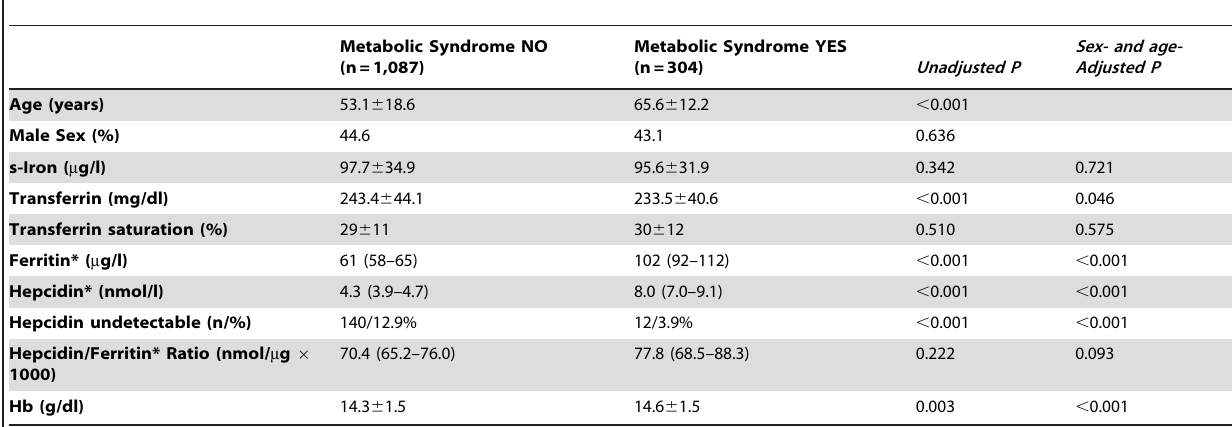
Table 2. Biochemical iron parameters in the VB population stratified for presence or absence of